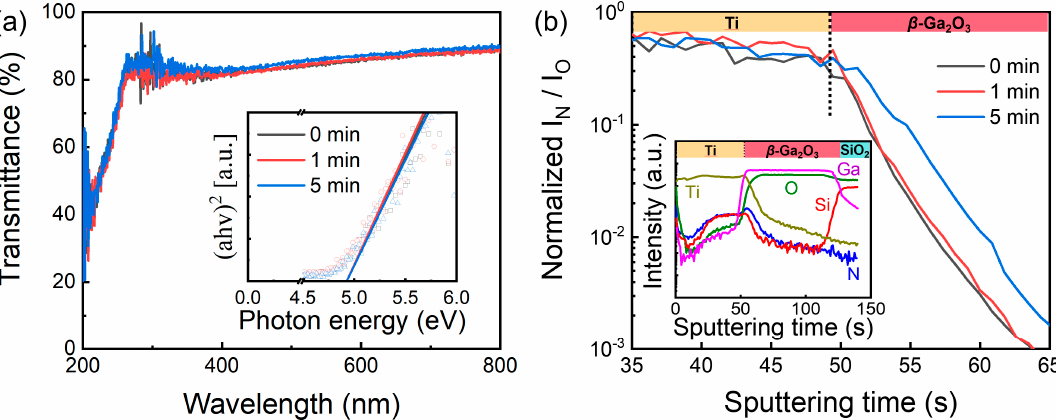
Figure 1. ( a ) Optical transmittance spectra and Tauc − plot and ( b ) normalized ratio of N over O from the SIMS depth profile of the β -Ga 2 O 3 thin film at different PN times. In the inset, SIMS depth profile of intrinsic β -Ga 2 O 3 thin film, which was indistinguishable from the depth profile of Ga, O, and N after 1 and 5 min PN treatment time.